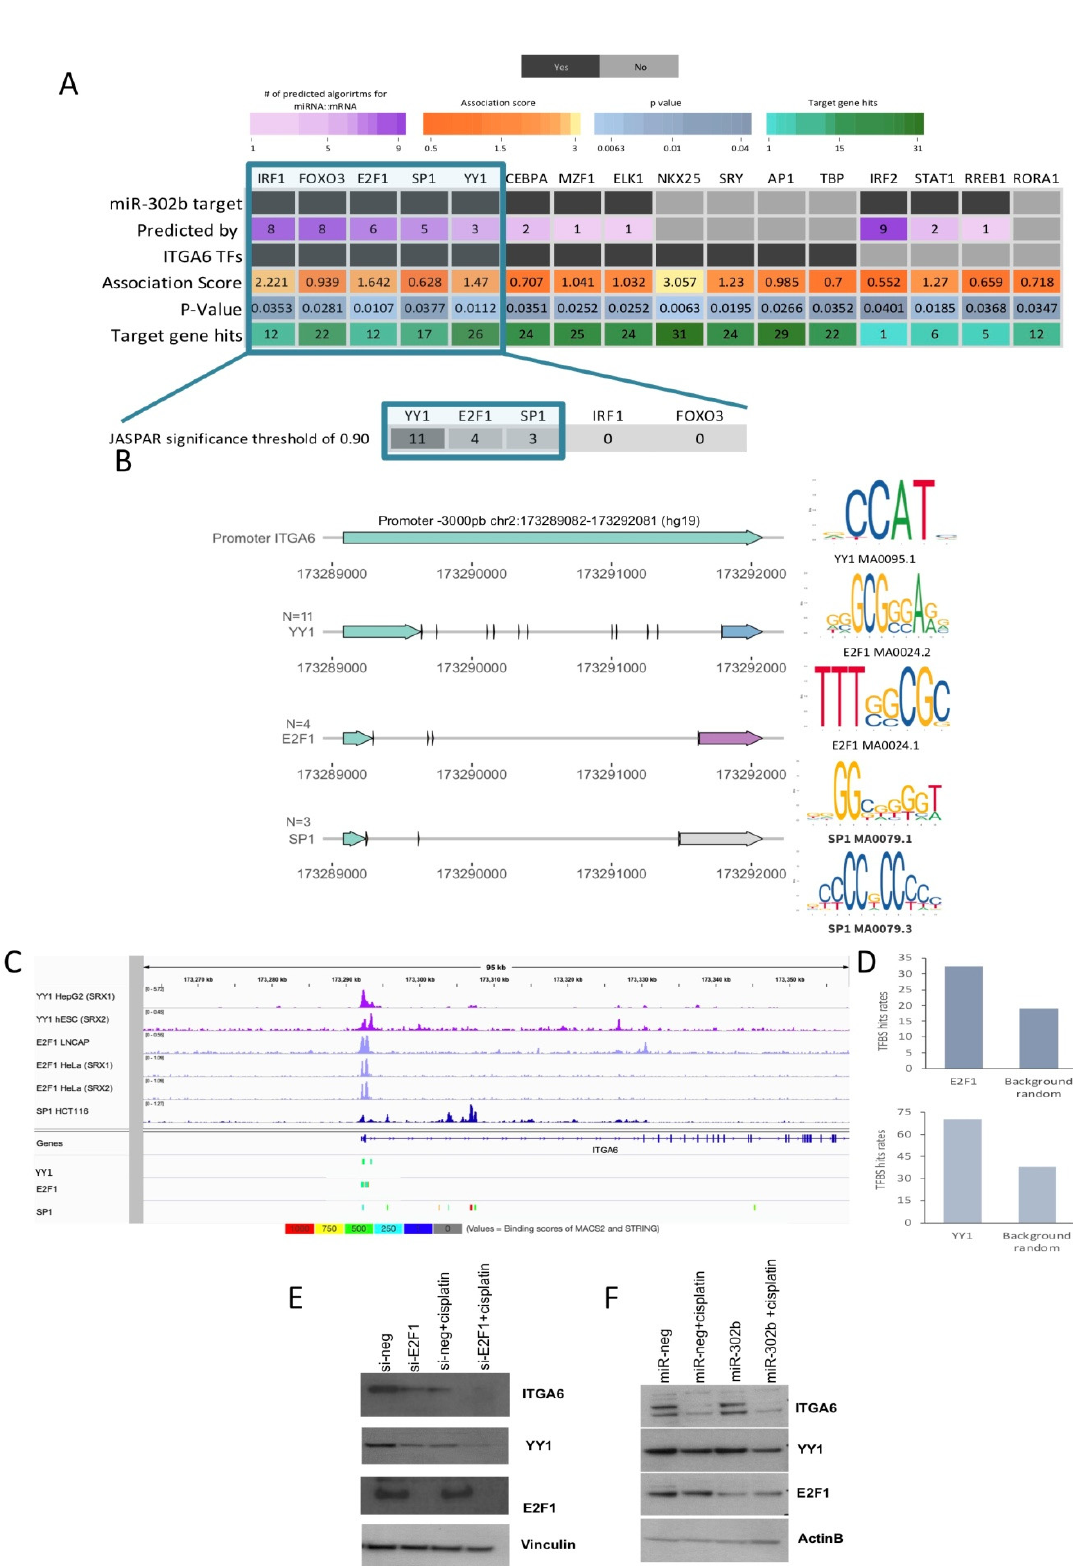
Figure 4. Summary of ITGA6 putative transcription factors (TFs) and their role behind the established mechanism by the combinatorial effect of miR ‐ 302b and cisplatin. ( A ) Overview of the study strategy to define possible TFs regulating ITGA6 expression. Through weight TFs matrices enrichment methods of down ‐ modulated genes in the in vivo assay (miR ‐ 302+cisplatin versus cel ‐ miR ‐ 67 negative control+cisplatin) possible TFs were identified. Only those TFs predicted as miR ‐ 302b targets and presenting motif binding sites to the promoter sequence of ITGA6 were